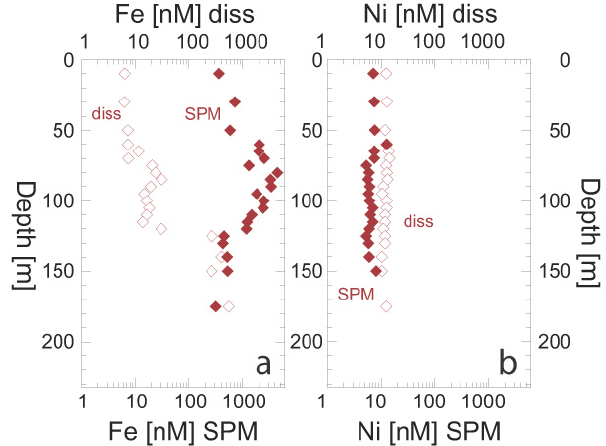
Fig. 3. Profiles of (a) Fe and (b) Ni for the Eastern Gotland Basin. Samples were collected early in January 2006, three months after the profiles shown in Fig. 2 and processed in the same way (see Sect. 3.2). Fig. 4. Profiles of pH and alkalinity in fall 2005 for the Eastern Got- land Basin. Data are from the Swedish Meteorological and Hydro- logical Institute’s monitoring program (Karlson et al., 2009), station BY-15 (which is identical to station 271 of this